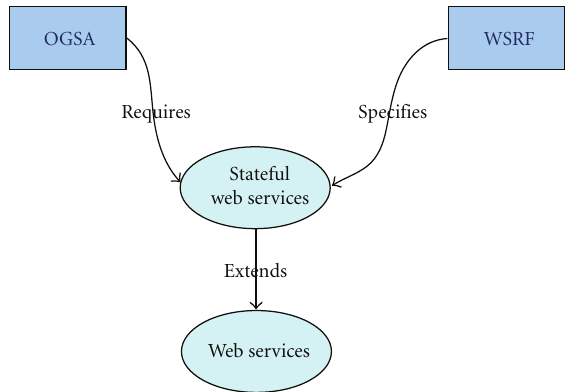
Figure 8: Relationship between OGSA, WSRF, and web